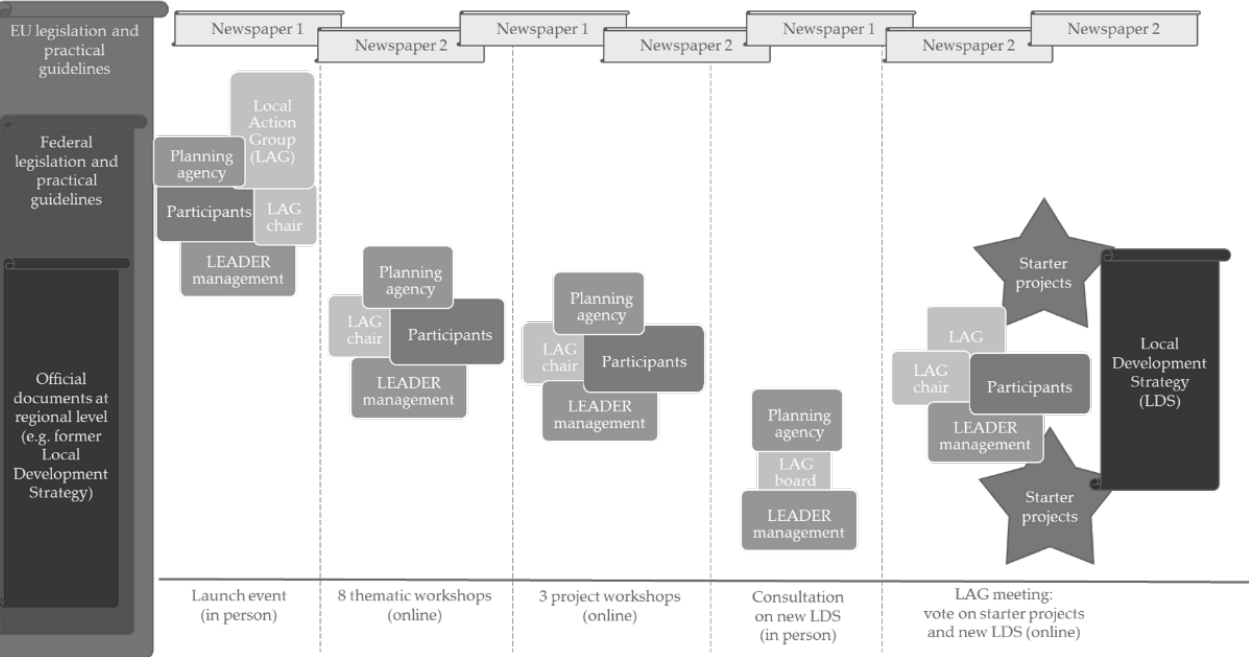
Figure 1. An overview of the observed LDS process, the involved actors, and relevant documents, including EU and federal legislation and articles in the two regional newspapers (authors’ draft).